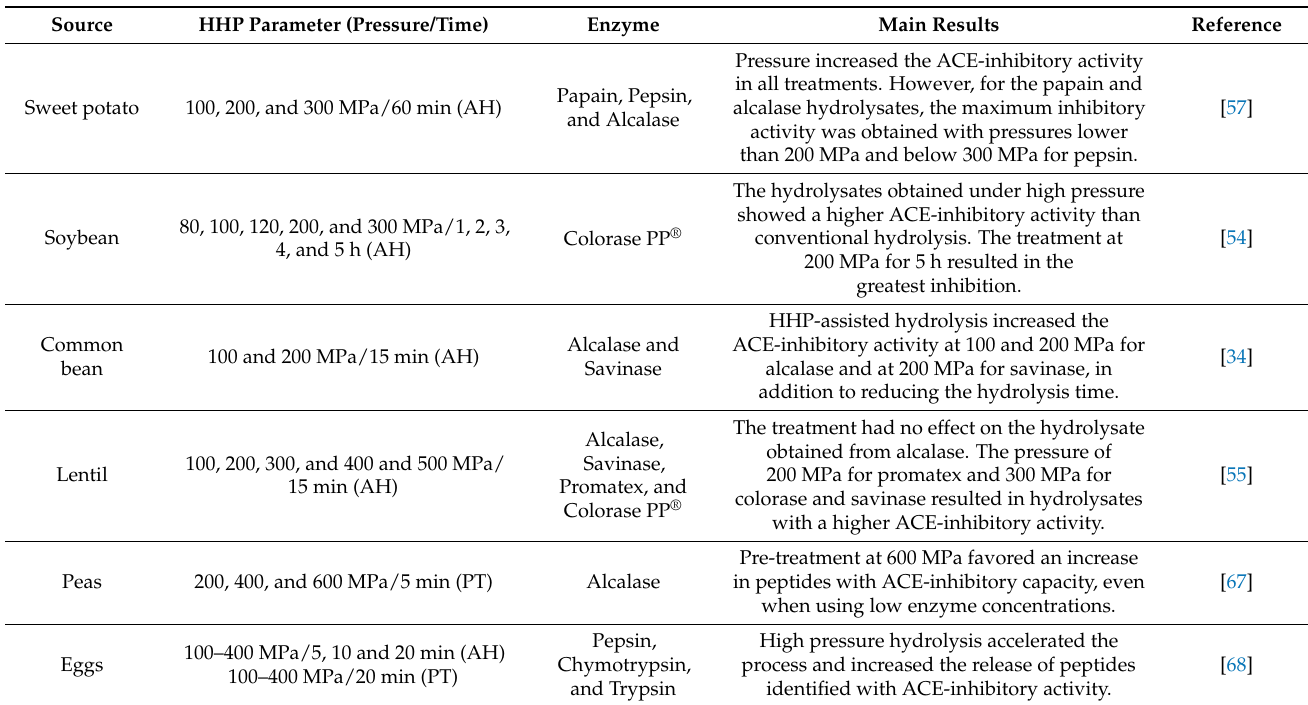
Table 1. Influence of HHP on the production of hydrolysates with antihypertensive